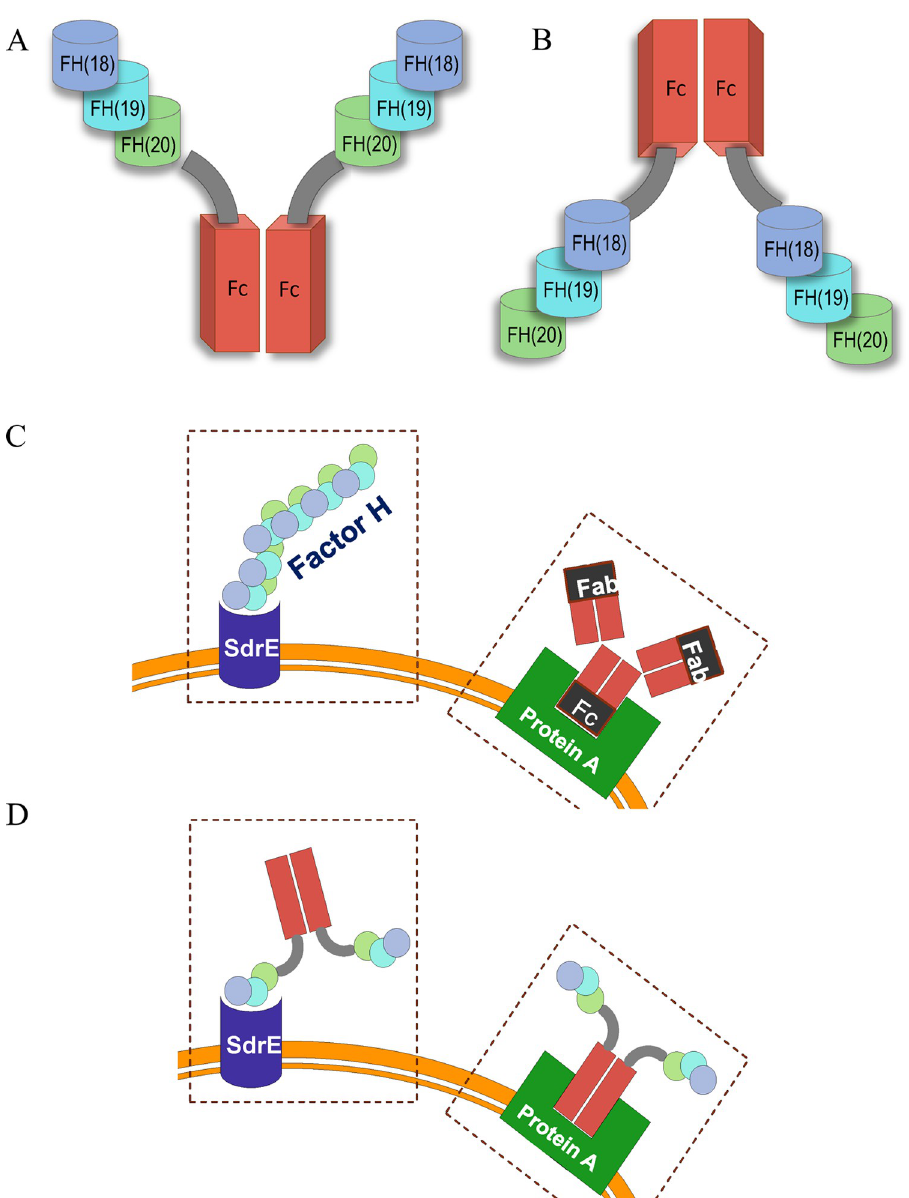
Fig 1. Structure and binding of FH, IgG, and FH-Fc to staphylococcal virulence factors Protein A and SdrE. A, Structure of the homodimeric fusion protein FH-Fc; IgG1 Fc region portrayed as rectangles, FH (CCP18-20) portrayed as cylinders, connected by the IgG1 hinge region. B, Reverse orientation of FH-Fc (Fc at the N-terminus and FH (CCP 18–20) at the C-terminus). C, C-terminus of FH bound by SdrE and Fc domain of IgG bound by Protein A. D, Schematic of FH-Fc fusion protein binding to SdrE and protein